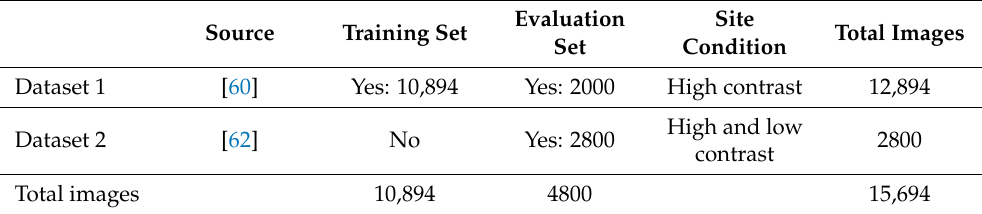
Table 2. Characteristics of the collected dataset.